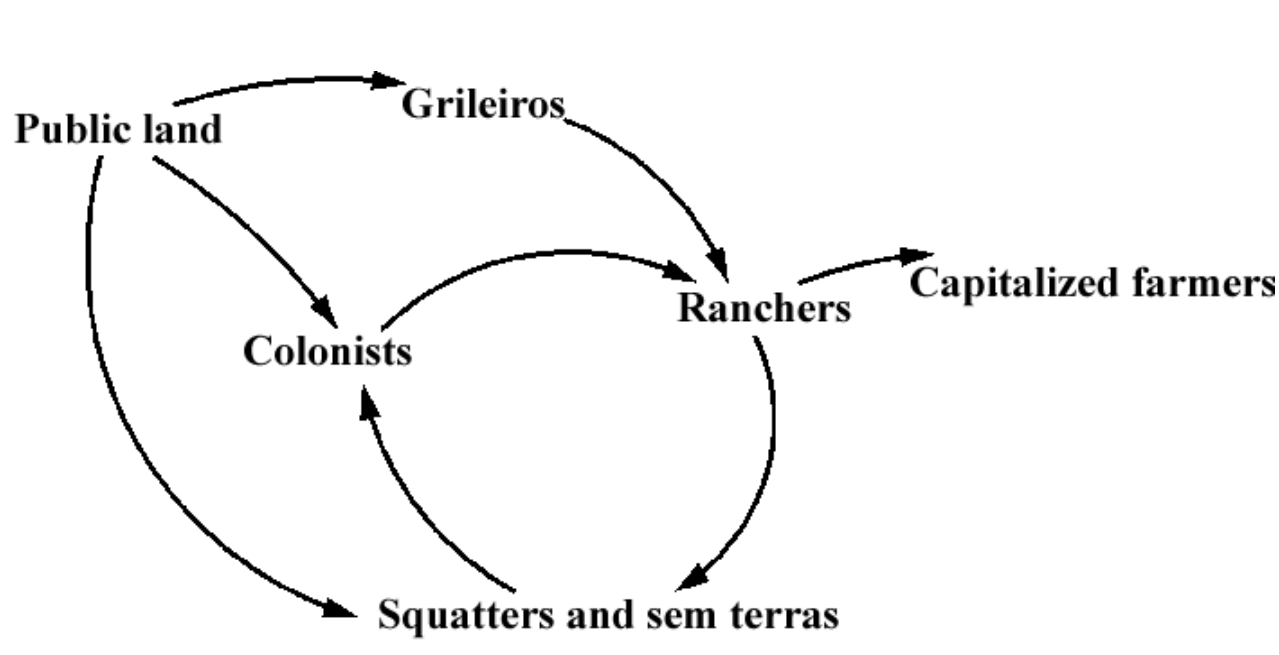
Fig. 3. Land holdings: transformations in the status of a given piece of land over